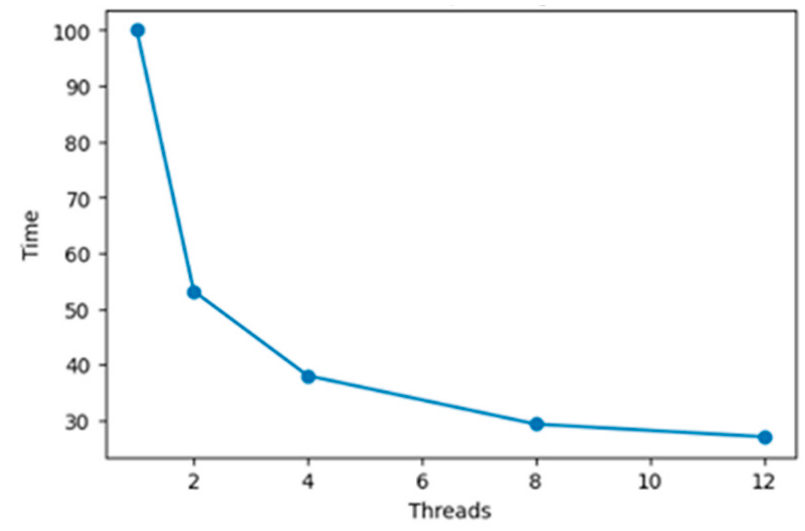
Figure 10. Measured normalized operating time vs. threads for 2 MB data .